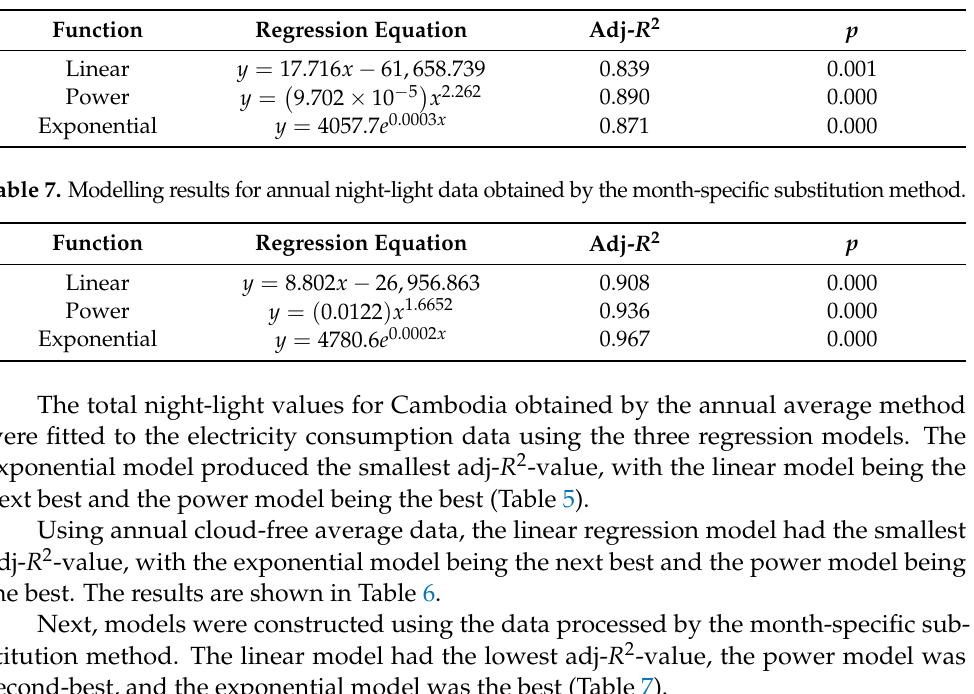
Table 6. Modelling results for annual night-light data obtained by the annual cloud-free average method. Function Regression Equation Adj- R 2 p Linear